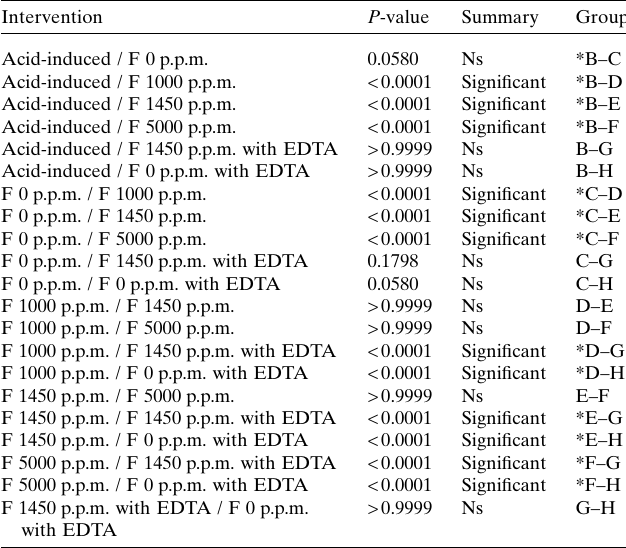
Table 2 Comparison of the mean of hydroxyapatite percentage in terms of relative abundance for each treatment group. Asterisks (*) indicate a significant difference. Ns = non-significant.